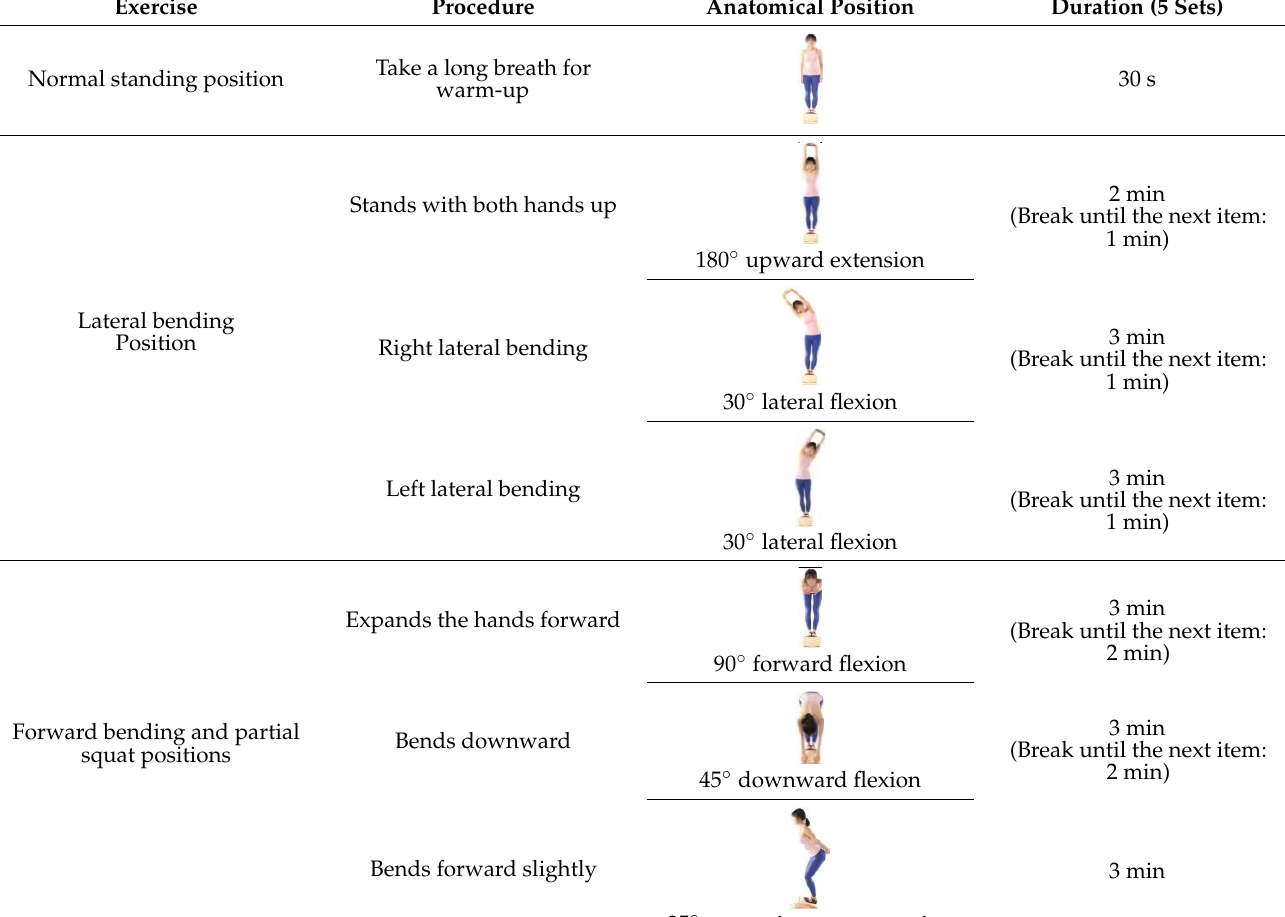
Table 3. Standing exercise program design. Table 3 . Standing exercise program design . Table 3 . Standing exercise program design . Table 3 . Standing exercise program design . Table 3 . Standing exercise program design . Table 3 . Standing exercise program design . Table 3 . Standing exercise program design . Table 3 . Standing exercise program design